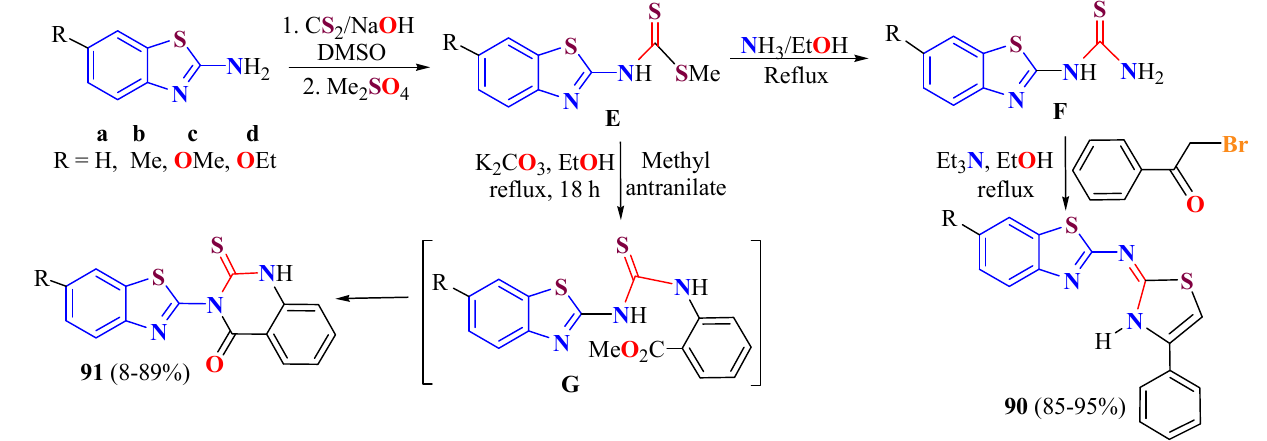
Scheme 37. The 6-substituted-TUBTs as intermediates to be cyclized to compounds 90 and 91 .